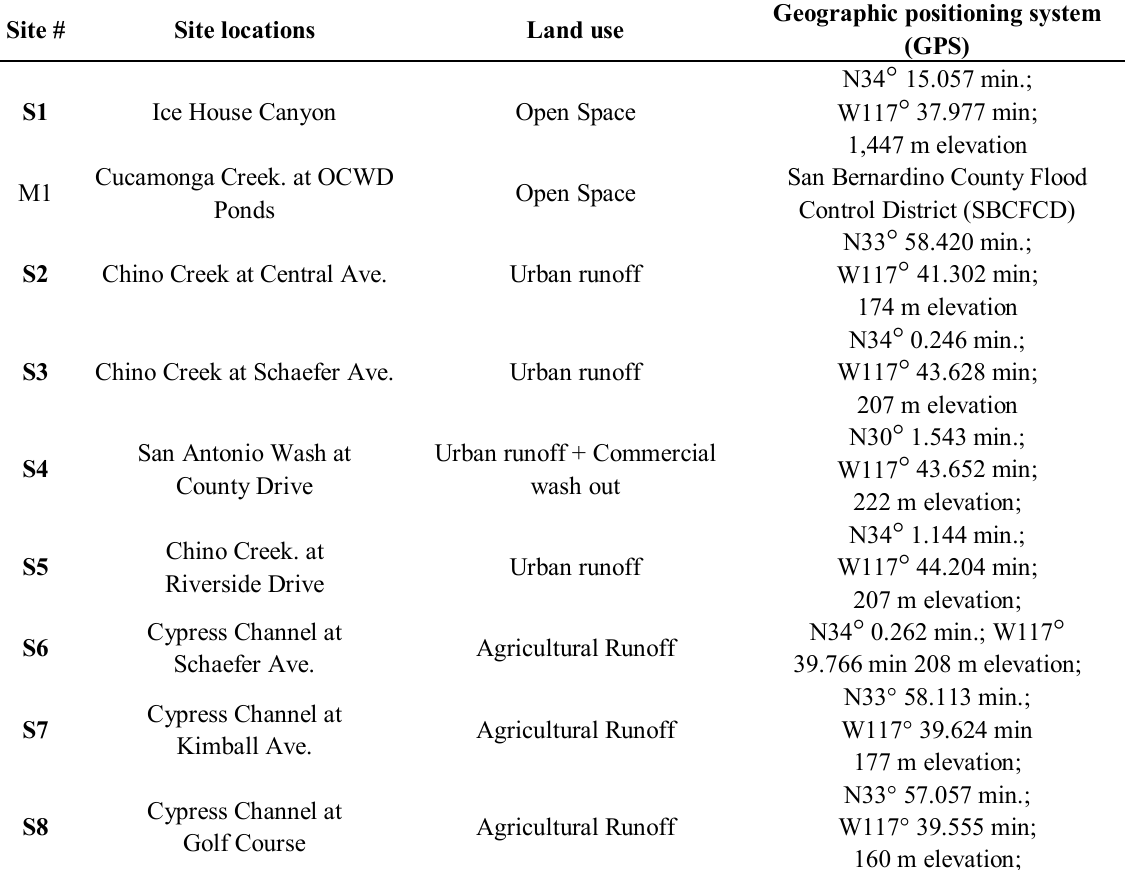
Table 1. Sampling locations for MSAR pathogen source evaluation study.